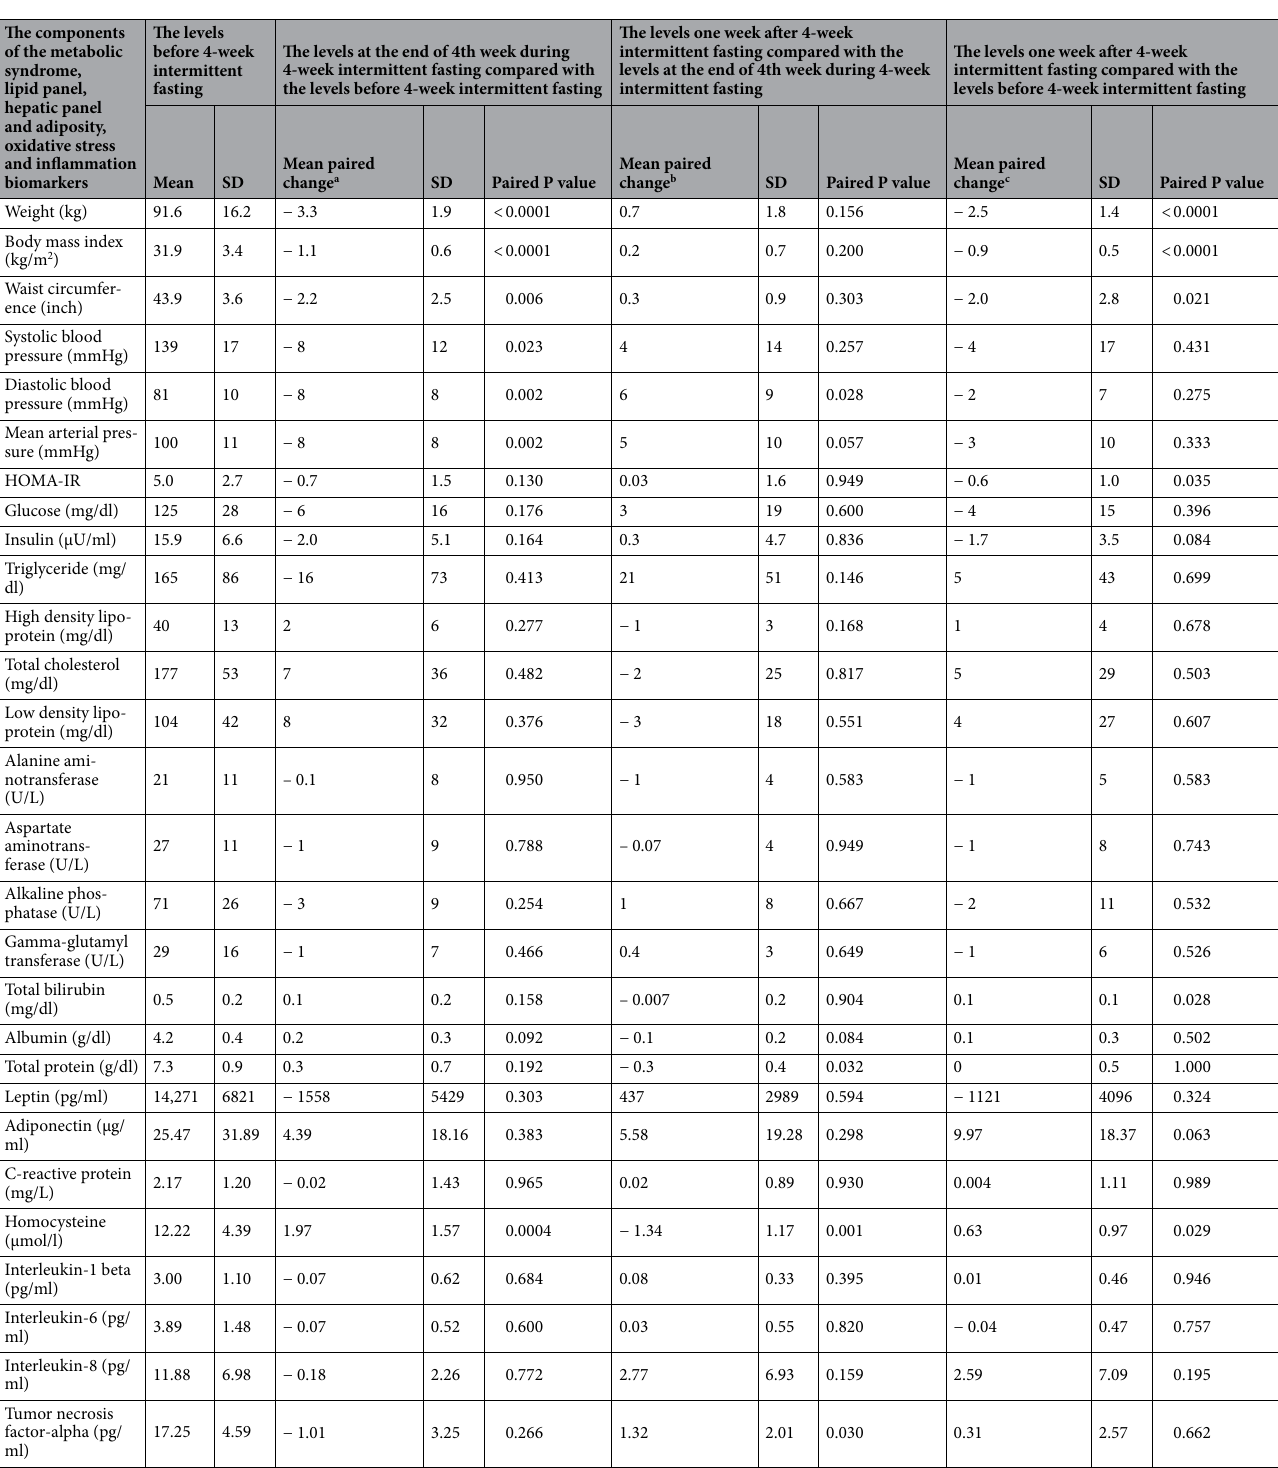
Table 1. The effect of 4-week intermittent fasting from dawn to sunset on the components of the metabolic syndrome, lipid panel, hepatic panel and adiposity, oxidative stress and inflammation biomarkers. a A positive mean paired change indicates an increase and negative mean paired change indicates a decrease in the levels measured at the end of 4th week during 4-week intermittent fasting compared with the levels measured before 4-week intermittent fasting. b A positive mean paired change indicates an increase and negative mean paired change indicates a decrease in the levels measured 1 week after 4-week intermittent fasting compared with the levels measured at the end of 4th week during 4-week intermittent fasting. c A positive mean paired change indicates an increase and negative mean paired change indicates a decrease in the levels measured 1 week after 4-week intermittent fasting compared with the levels measured before 4-week intermittent